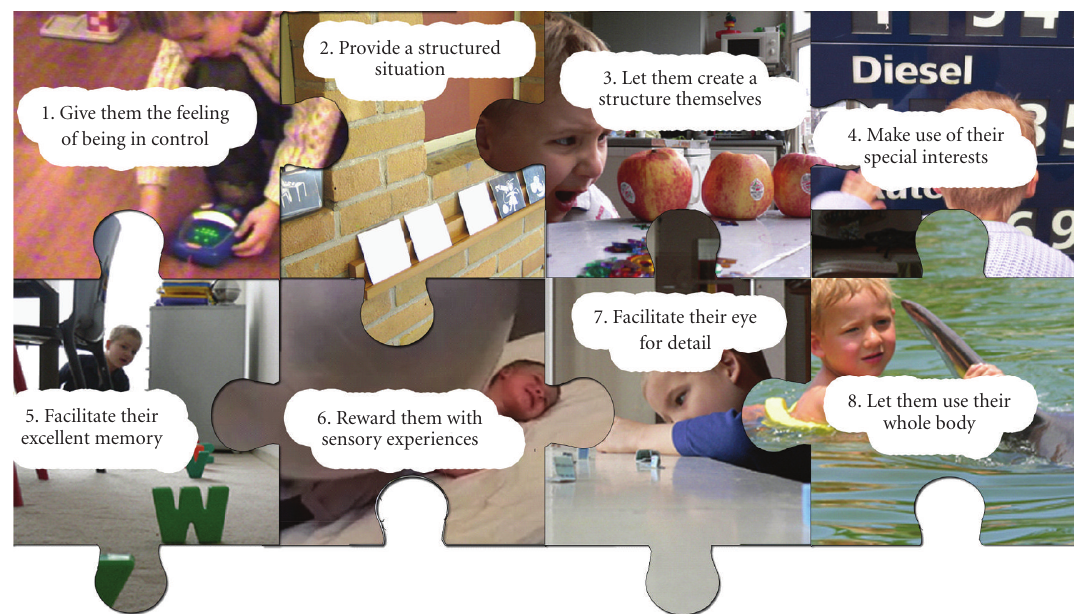
Figure 4: An overview of the design guidelines on how to design for children with autism. This puzzle is unfinished on purpose, to indicate that we expect more insights will follow in the coming years, and want to invite others to think along and help to extend it.